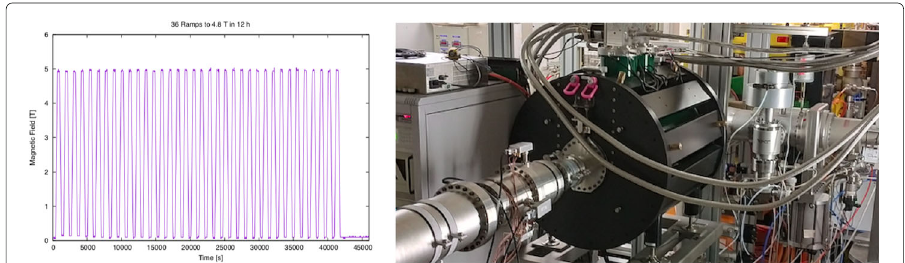
Fig. 10 Left: Sequence of ramps to 5 T at a ramp rate of 0.76 T/s measured with a hall probe. Right: A picture of the Siberian snake installed inside COSY (see also Table